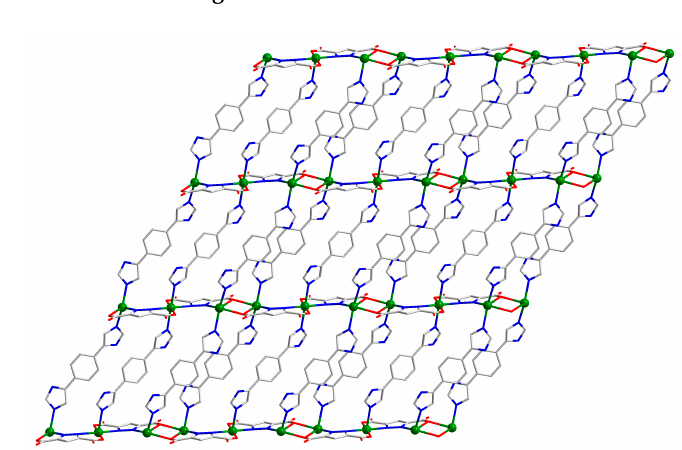
Figure 2. 1D chain structure of 1 .